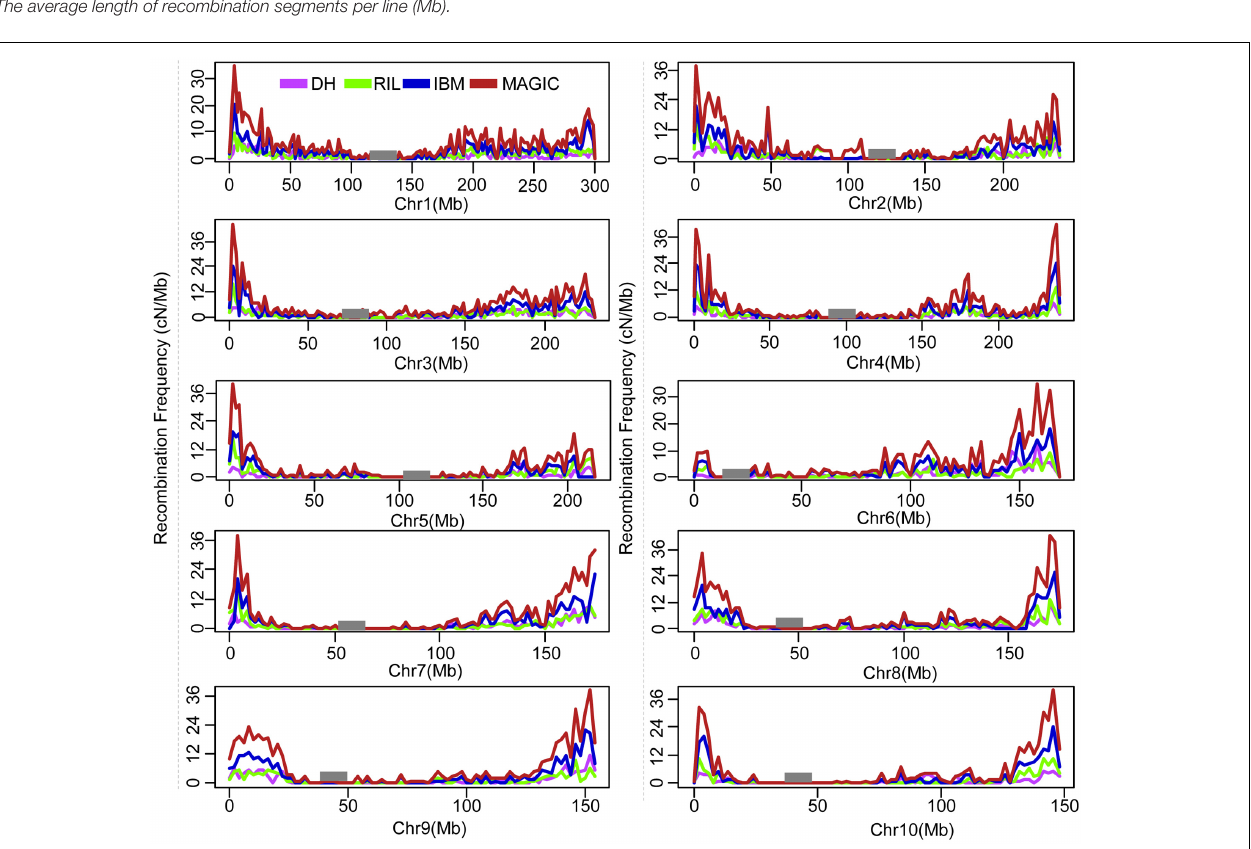
FIGURE 1 | Genome wide of recombination frequency variance for four different population types. Recombination frequency of cM/Mb within 2 Mb window size was counted. Black rectangle is the centromeric position. DH, double haploid; RIL, recombination inbred lines; IBM, intermated B73xMo17; MAGIC, multi-parent advanced generation inter